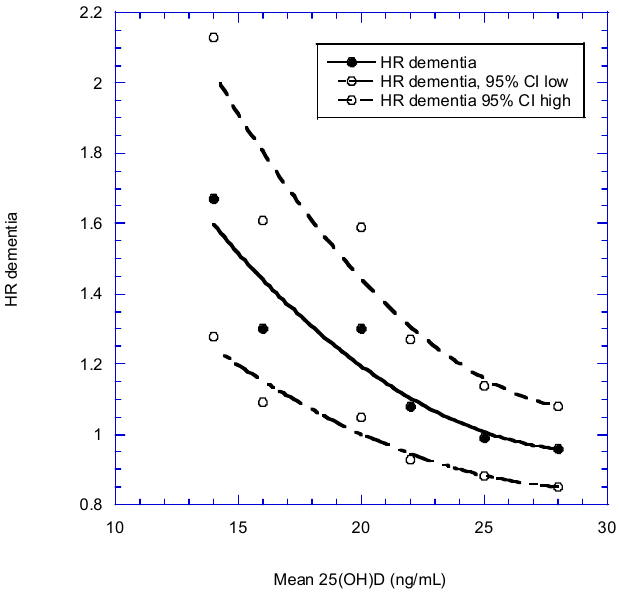
Figure 2. Hazard ratio (HR; mean and 95% confidence interval [CI]) for dementia according to mean 25-hydroxyvitamin D [25(OH)D] concentration in each of the six studies included in the meta-analysis [138].